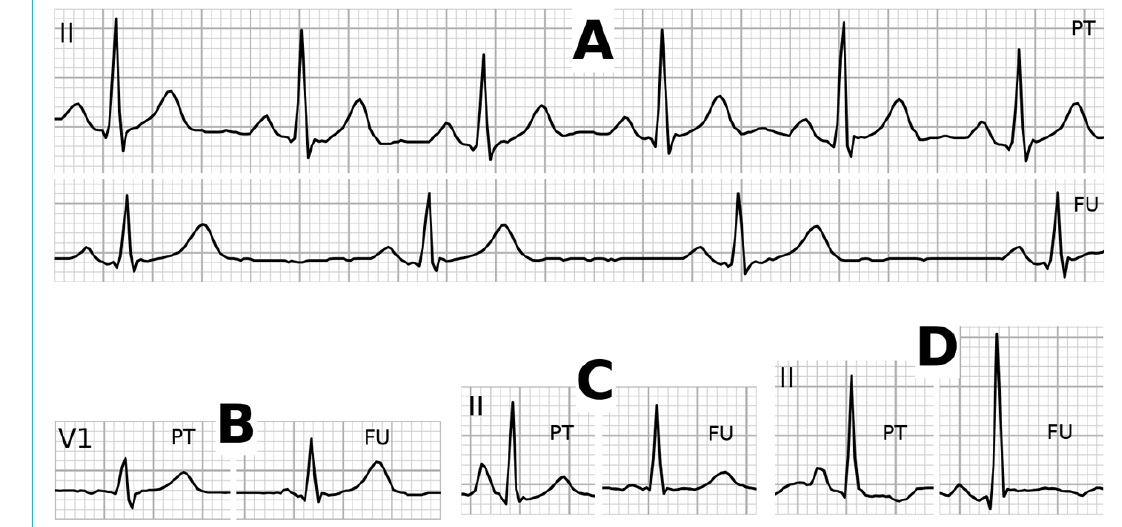
Figure 2: Examples of positive ECG signs by pneumothorax (PT) with resolution at follow-up (FU) in the same patient. A. Lead II with phasic QRS voltage changes. B. Lead V1 with P-wave inversion. C. Lead II with P pulmonale. D. Lead II with baseline shift before the P-wave